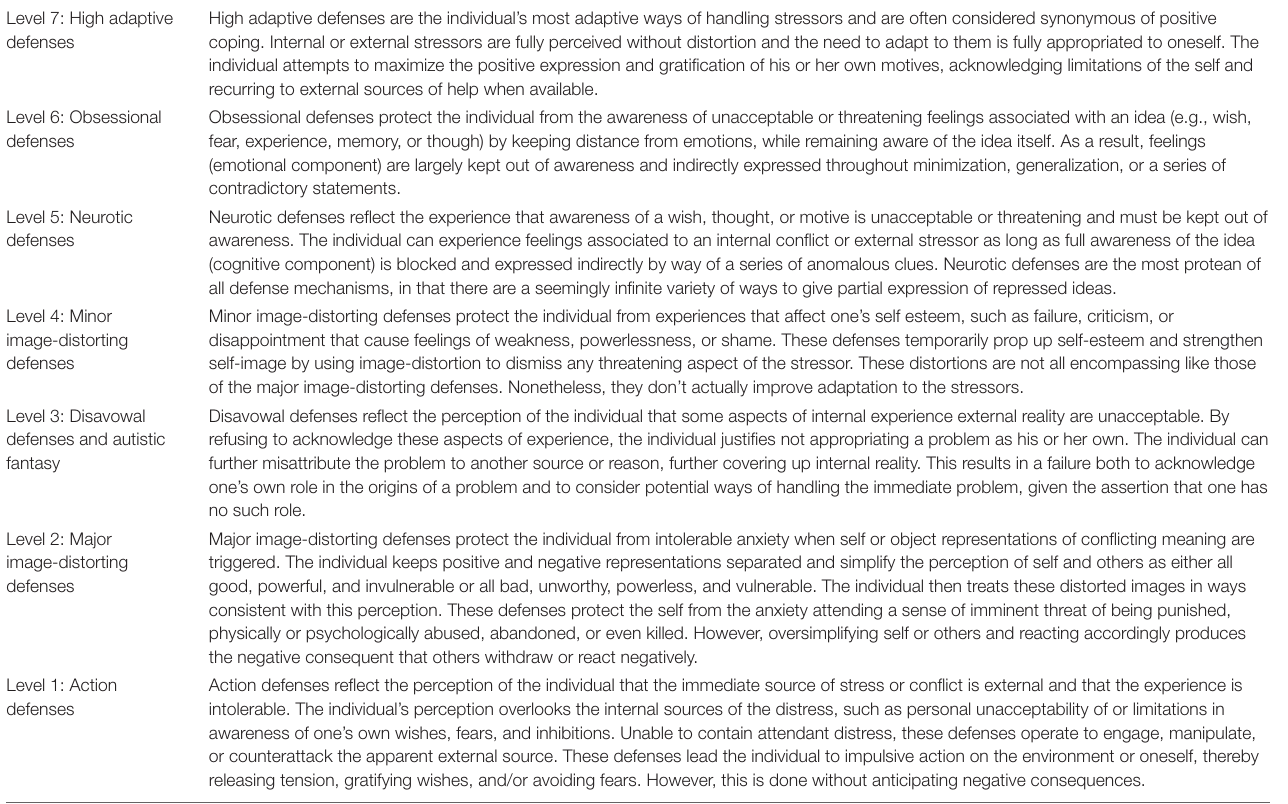
TABLE 1 | The defensive function of the seven hierarchically ordered defense